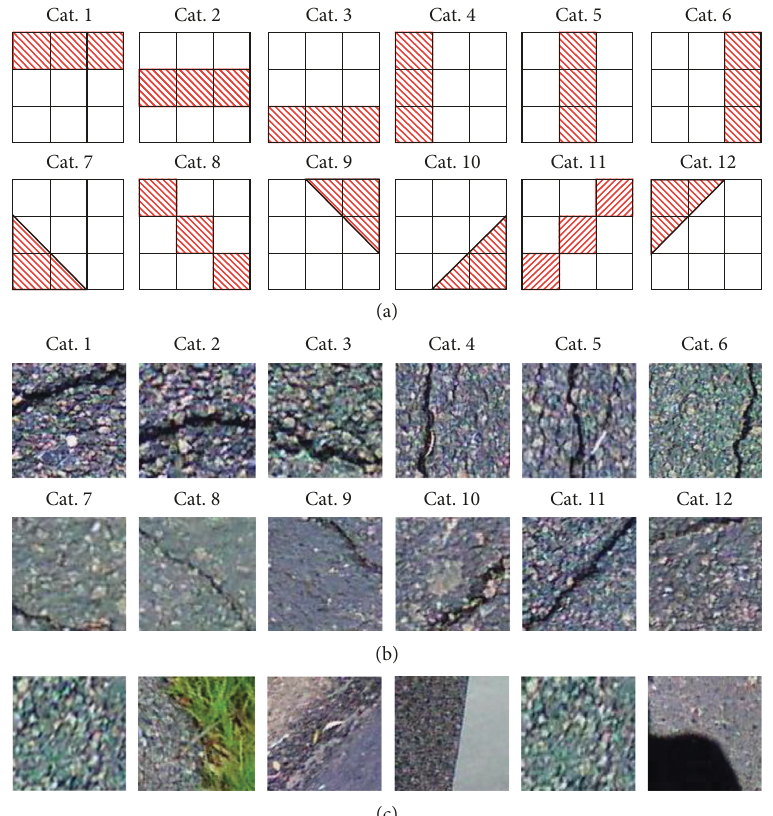
Figure 2: (a) Categorization method based on the position of a crack in each tile, indicating a defective section. (b) Sample of tiles in 12 categories. (c) Category 13 th sample images of noncracked tiles.